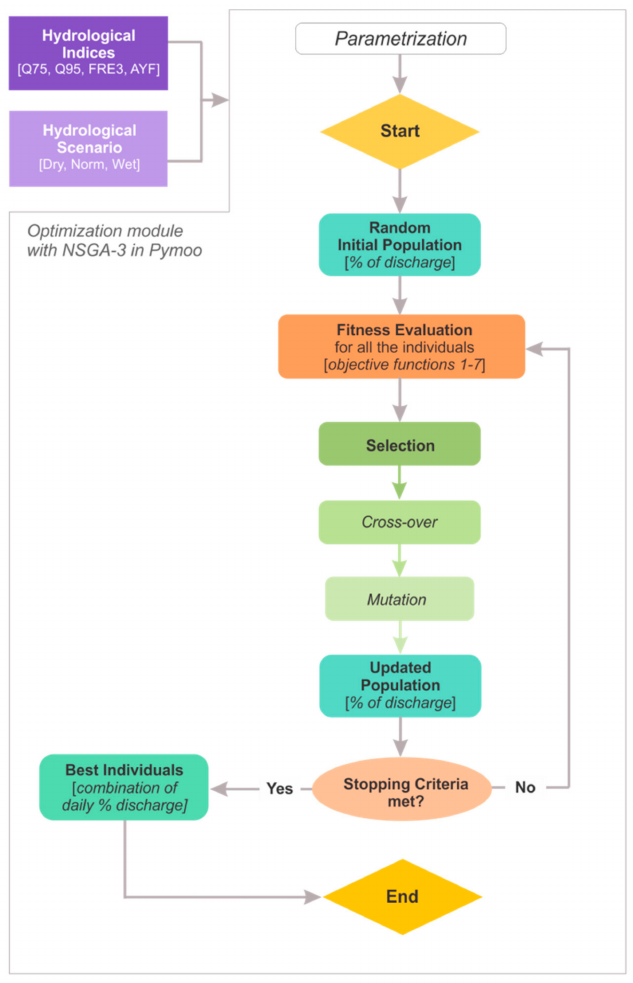
Figure 7. Optimization problem structure employed to the Pas River. The main box shows the module structure of the Non-Sorted Genetic Algorithm-3 (NSGA-3) in Pymoo—a multi-objective optimization module in Python [81]. Two external modules, Hydrological Scenario and Hydrological Indices, calculated the hydrological scenarios to be inputted into the Pymoo module and the hydrological variables,